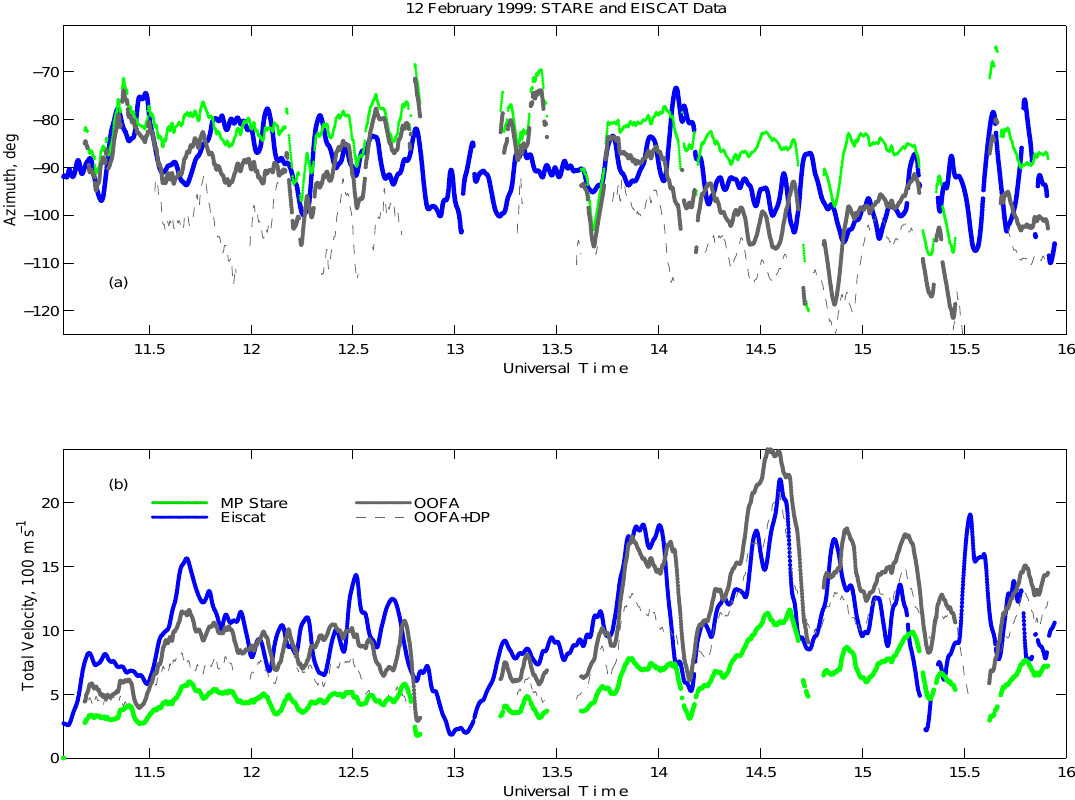
velocity (panel (b) ), grey lines; dashed grey lines are the similar azimuth and velocity if the OOFA is applied to the STARE DP